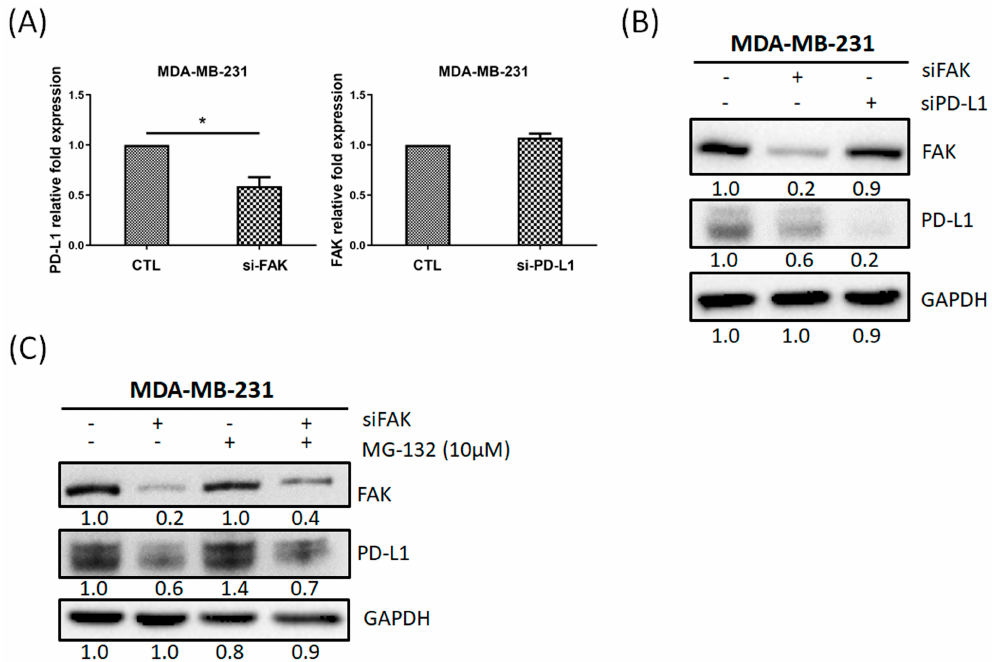
Figure 5. PD-L1 is regulated through gene expression of FAK in TNBC cells. ( A ) FAK inhibition decreased PD-L1 gene expression, but PD-L1 inhibition did not a ff ect FAK gene expression in MDA-MB-231 cells. ( B ) Knockdown of FAK decreased PD-L1 protein expression, but knockdown of PD-L1 did not a ff ect FAK protein expression. ( C ) MDA-MB-231 cells were divided into control, transfected FAK siRNA for 24 h, MG-132 (10 µ M) treatment for 24 h, and transfected FAK siRNA 24 h, then combined with MG-132. Data from three independent experiments were used for statistical analysis and * p <